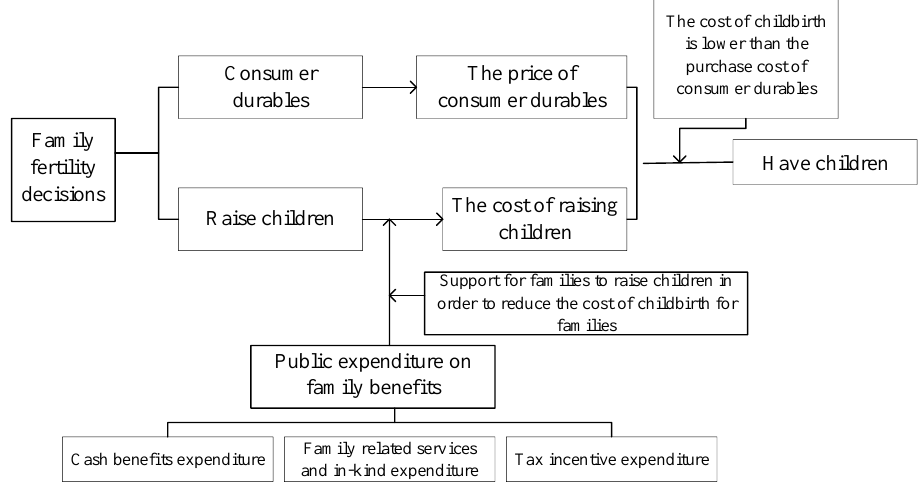
Figure 5. Modified “ New Home Economics ” framework diagram.